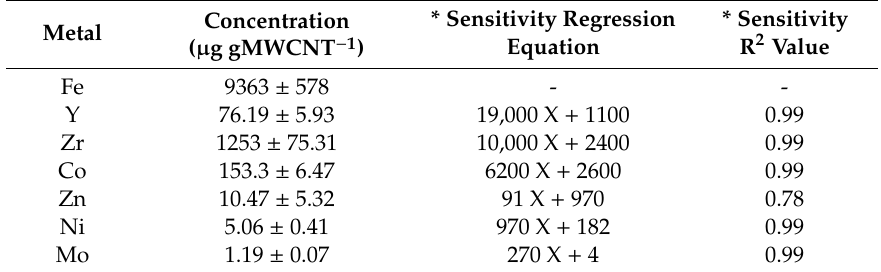
Table 1. Contents of trace metal residual elements in multi-walled carbon nanotubes (MWCNTs) determined by ICP-MS.